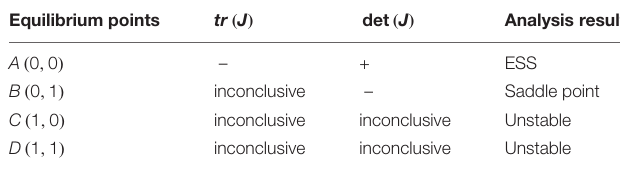
TABLE 5 | Local equilibrium stability analysis in case